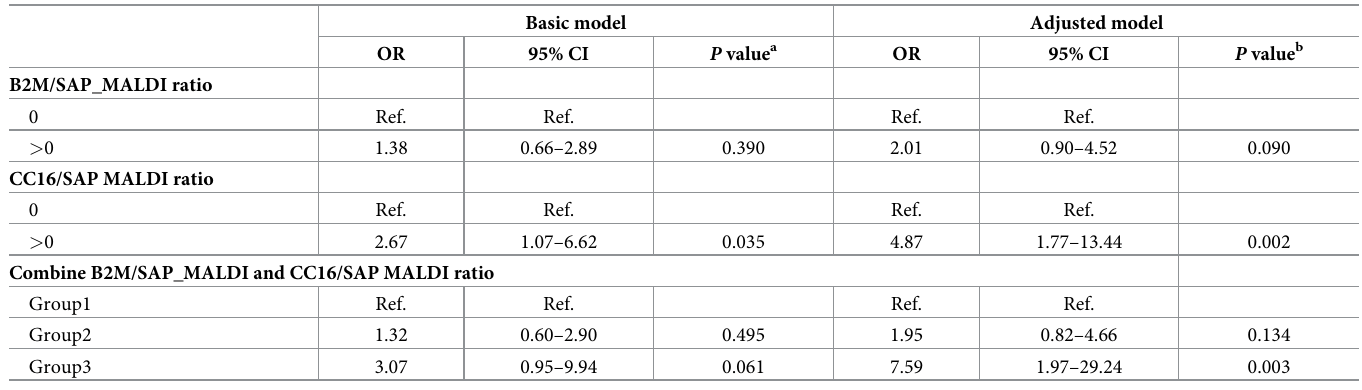
Table 3. The logistic regression